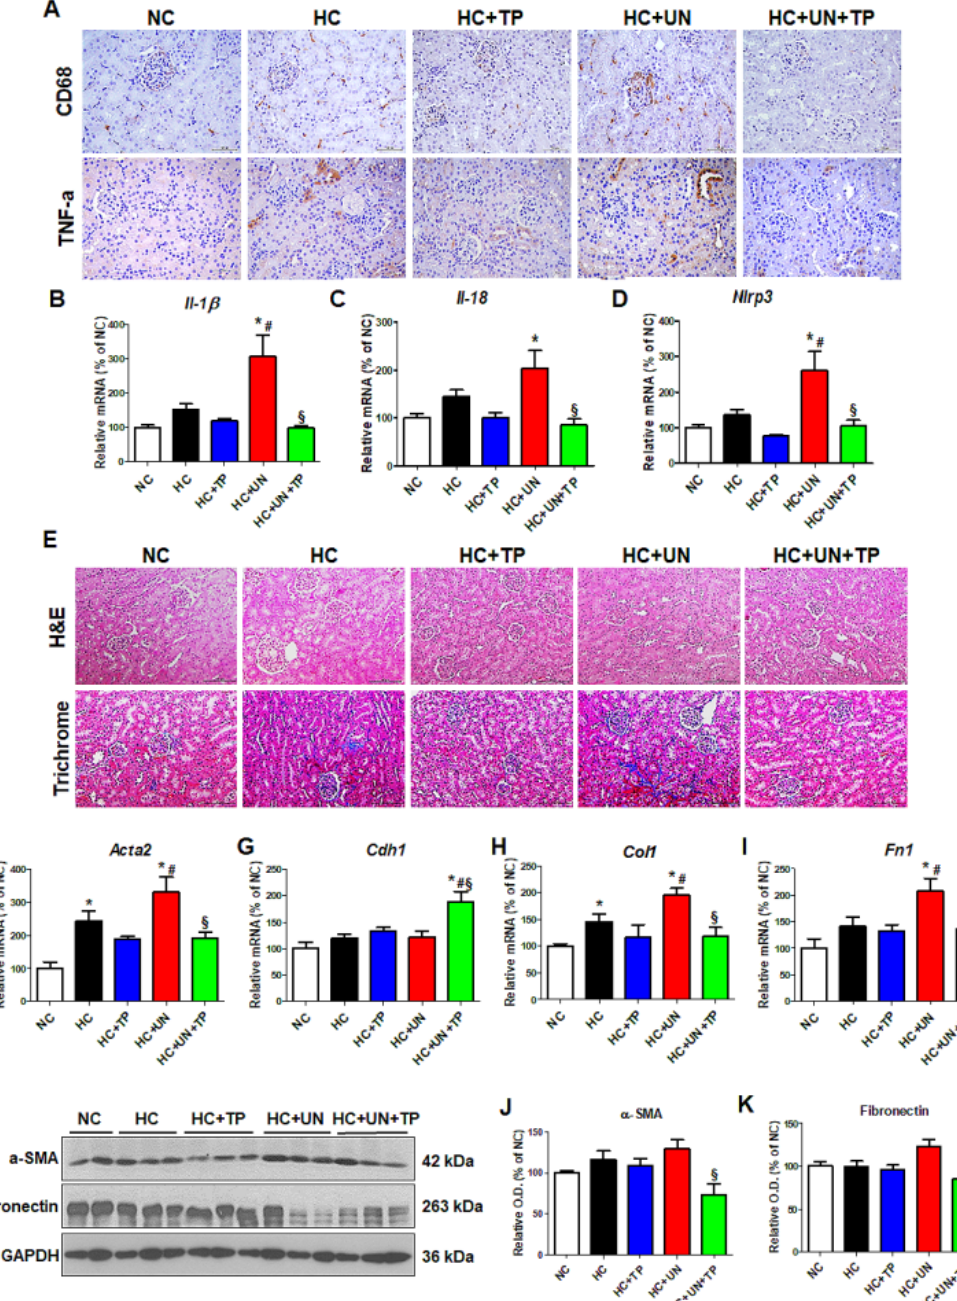
Figure 5. Abnormal lipid metabolism and oxidative stress induced by high-cholesterol diet affect inflammation and fibrosis progression in kidney tissue. ( A ) Representative images of TNF- α and CD68 staining of kidney tissue. Scale bars, 100 μ m. ( B – D ) Real-time RT-PCR was performed to determine mRNA levels of Il-1 β , Il-18 , and Nlrp3 . ( E ) Representative images of hematoxylin and eosin staining and trichrome staining of kidney tissue. Scale bars, 100 μ m. ( F – I ) Real-time RT-PCR was performed to determine mRNA levels of Acta2 , Cdh1 , ColI , and Fn1 . ( J , K ) Representative western blot for α -SMA, fibronectin, and GAPDH. Relative protein expression was determined using densitometry. Differences among the groups were analyzed by one-way non-parametric ANOVA, followed by Tukey’s multiple comparison test. Data represent mean and SEM. * p < 0.05 vs. NC, # p < 0.05 vs. HC, § p < 0.05 vs. HC+UN. LDL, low-density lipoprotein; TP, topiroxostat; UN, uninephrectomy; NC, normal control; HC, high-cholesterol.